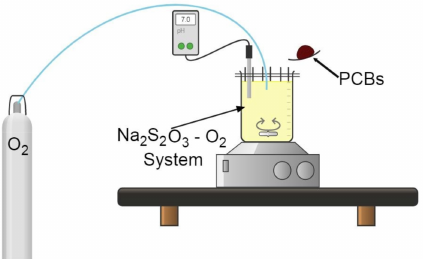
Figure 2. Experimental array used for the copper leaching